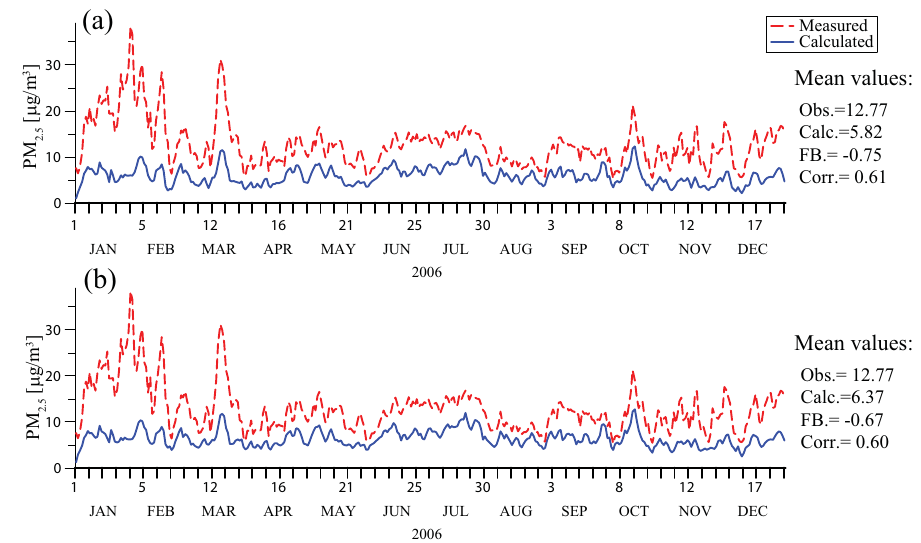
Fig. 10. Evaluation of the simulated total PM 2 . 5 concentrations (µgm − 3 ) from (a) the recent, and (b) the revised versions of DEHM against measured data from the EMEP network. The revised version includes SOA concentrations, as well as using the alternative sea-salt emissions. Total PM 2 . 5 in DEHM includes black carbon, organic carbon (primary and secondary), sea salt and secondary inorganic aerosol.